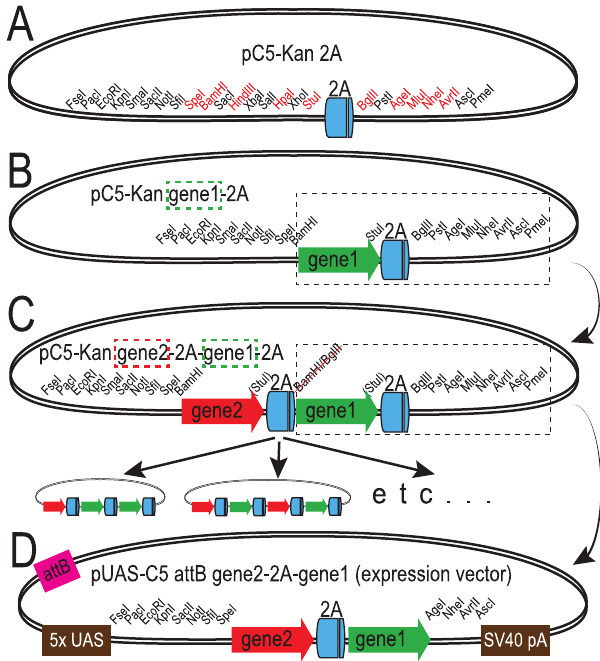
Figure 1. Outline of vector design for cloning 2A peptide- linked transgenes. A. Diagram of pC5-Kan 2A, a vector containing a codon-optimized 2A peptide coding sequence flanked on each side by multiple cloning sites that facilitates cloning. Restriction sites in frame with the 2A sequence are shown in red. B. General procedure for making multimeric 2A-linked transgenes. A fragment cut at the 5 9 end with BamHI and at the 3 9 end with any of the unique restriction enzymes following the 2A coding sequence (boxed region) can then be inserted 3 9 of the 2A sequence in another vector cut with BglII and the second chosen enzyme, creating the vector shown in panel C. This process creates a BamHI/BglII hybrid site that is in frame with the first coding sequence (red arrow), and leaves the BamHI and BglII sites unique so they can be used again if required. The process of adding a gene-2A cassette can be repeated using this method to create the desired construct. Examples are shown at the bottom. D. Diagram of an expression vector demonstrating the final step of the cloning procedure. The pUAS-C5 vector contains the same multiple cloning site as the pC5-Kan shuttle vector and has been modified with an attB site for phiC31-mediated integration into genomic attP sites.